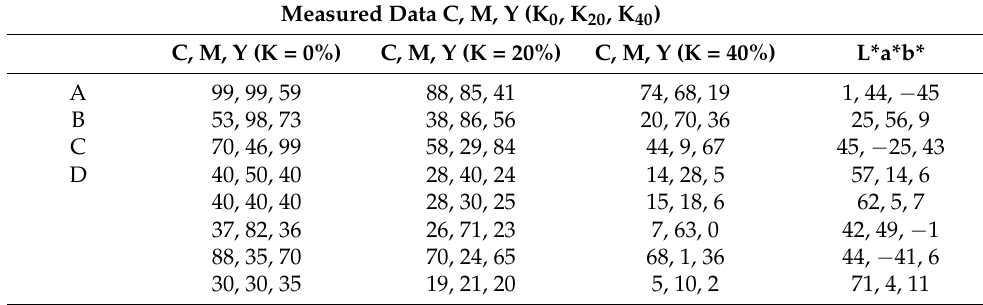
Table 1. CMYK formulations of twin dyes.